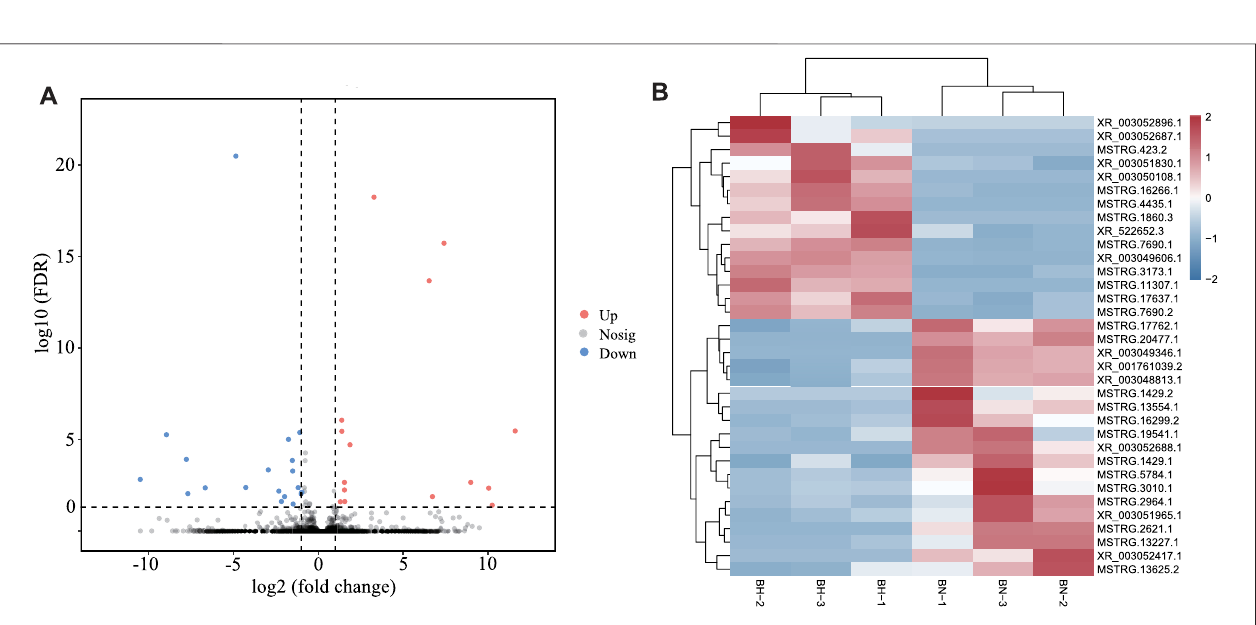
Frontiers in Genetics |